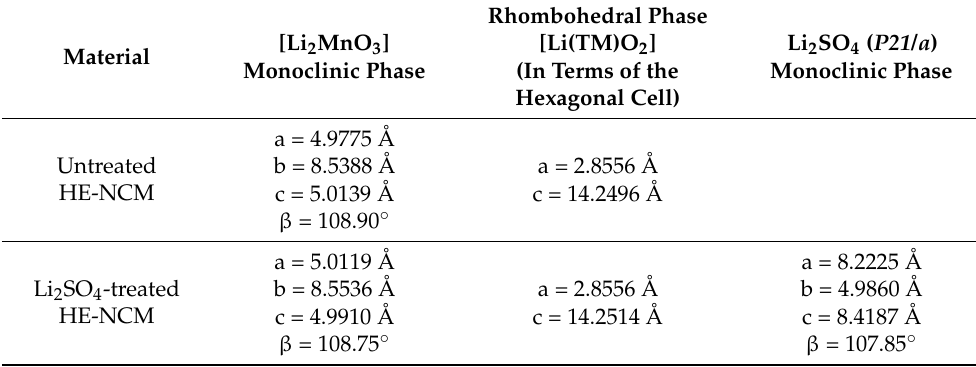
Table 1. Lattice parameters of the Li 2 MnO 3 monoclinic ( C2/m ), Li(TM)O 2 rhombohedral ( R-3m ), and Li 2 SO 4 ( P21/a ) phases (components) of HE-NCM materials according to XRD measurements and Rietveld